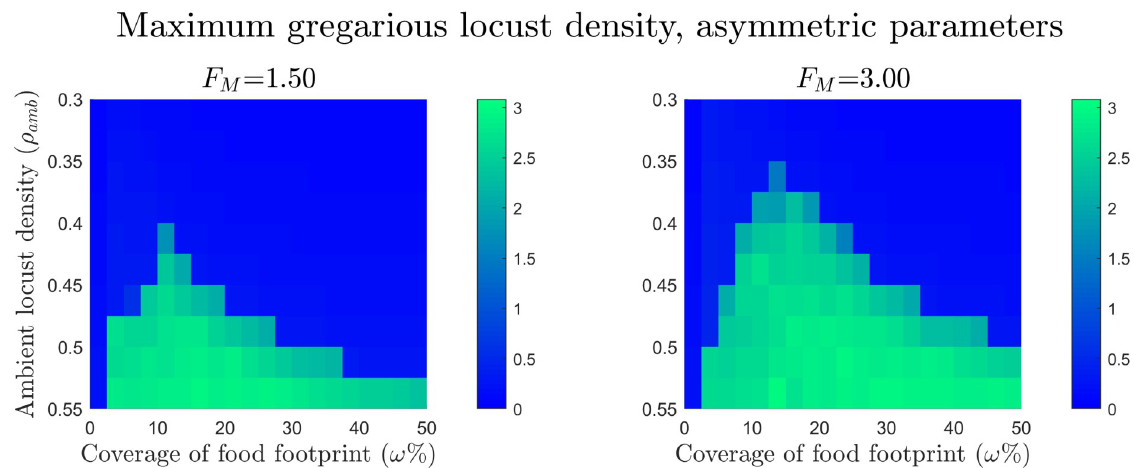
Fig 5. Maximum gregarious locust density for the asymmetric gregarisation parameters with varying food footprint sizes and initial ambient locust densities. For the simulations, x = [0, 3/0.14] with periodic boundary conditions and t = [0, 12.5]. The initial condition for locust densities is given by Eq (22) and food initial conditions are given by Eq (23). Ambient locust density ranges from ρ amb = 0.3 to ρ amb = 0.55, food footprint ranges from ω = 0% to ω = 50%, the food mass F M = 1.5 and 3, and the consumption rate κ = 0.18. The plots show the maximum peak gregarious density for the varying food footprint sizes and ambient locust densities. In the blue regions there was no group formation and in the green regions there was successful group formation. From this we can deduce that food lowers the required time forgroup formation and again this is more pronounced within an optimal food